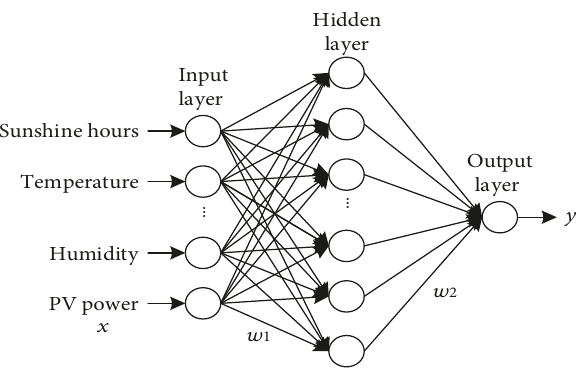
Figure 1: The structure of BP neural